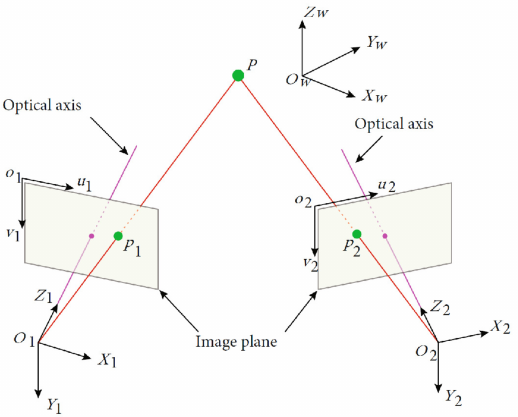
Figure 9. The principle of binocular